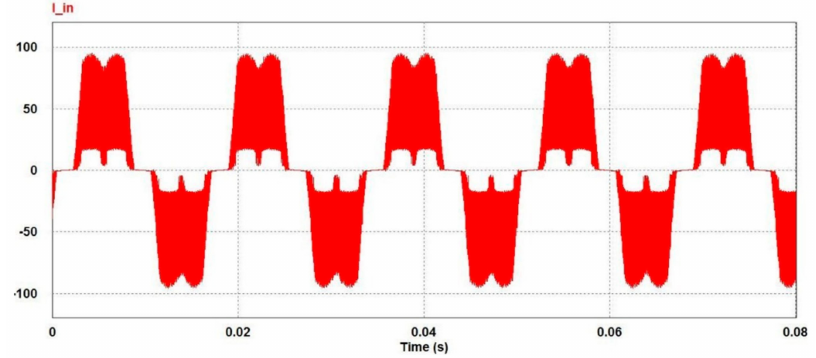
Figure 8. Waveform of the input phase current of the IH equipment without an